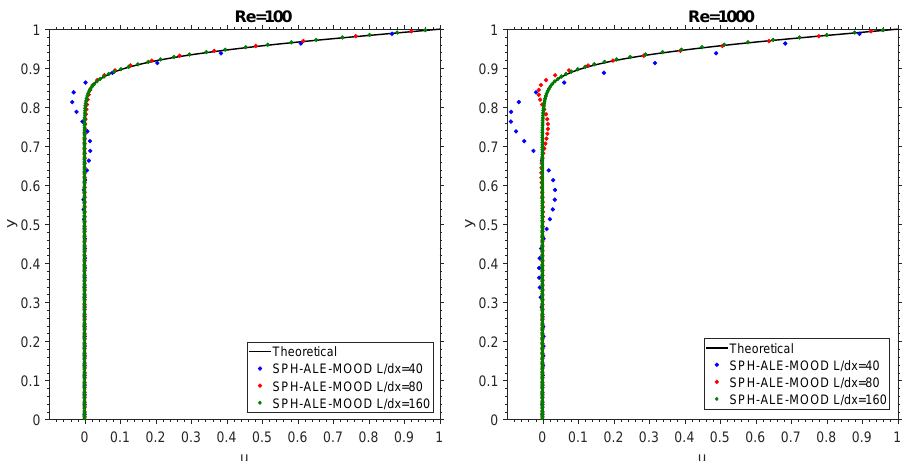
Figure 19. Convergence analysis for the Couette flow Re = 100 at t = 0.2 ( left ) and Re = 1000 at t = 2 ( right